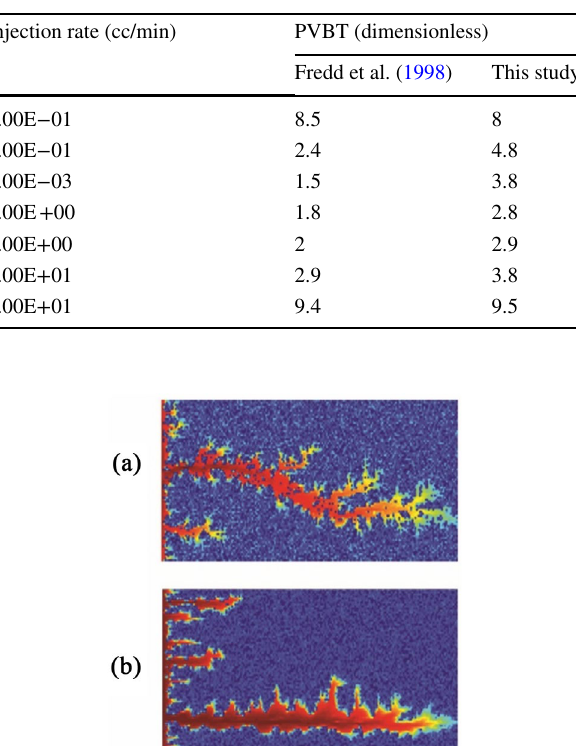
Fig. 8 Investigation of the effect of acid concentration on two-phase